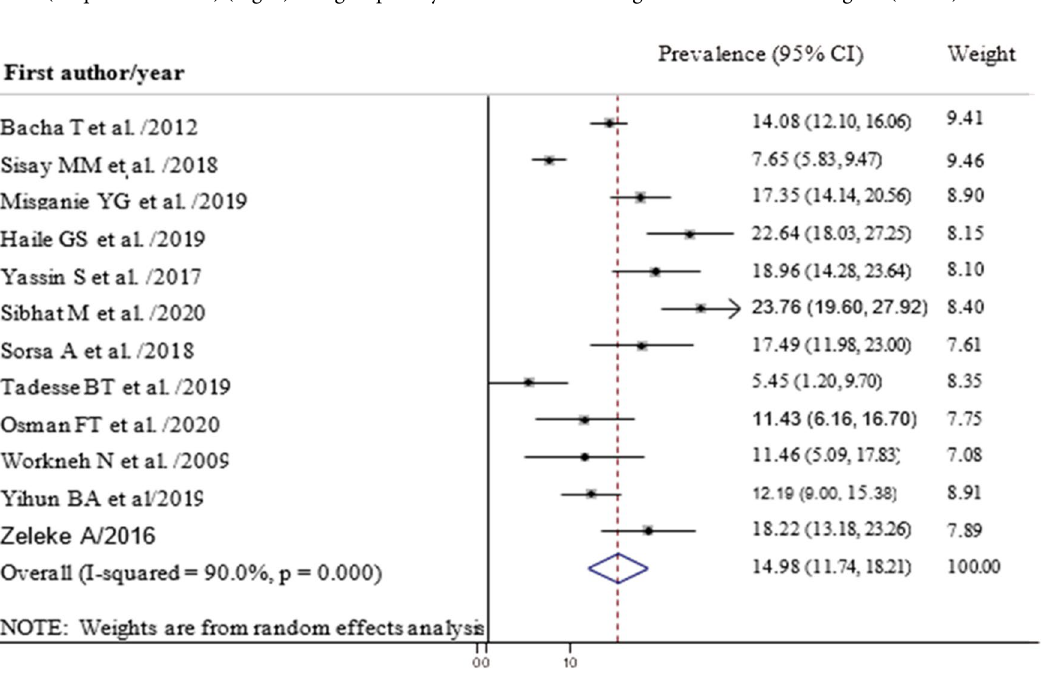
Figure 2. Forest plot showing the prevalence of anti-retroviral treatment failure among children in Ethiopia,